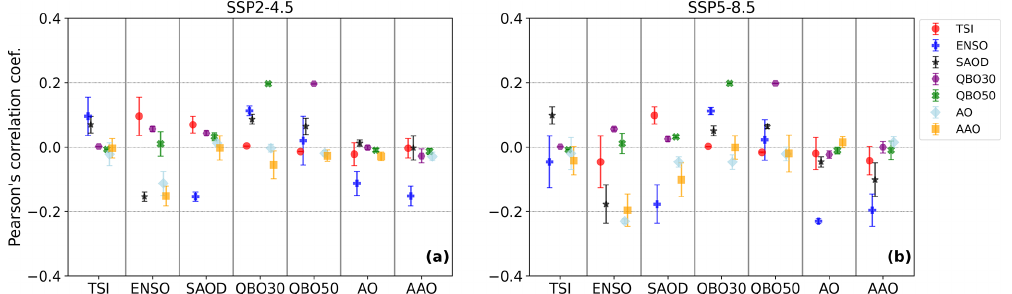
Figure A2. Pearson’s linear correlation coefficients for different covariate variables (proxy variables) of the SOCOLv4 simulations for the 2015–2099 period: (a) for SSP2-4.5 and (b) for SSP5-8.5. Error bars represent the 1 σ standard deviation of the correlation coefficients between ensemble